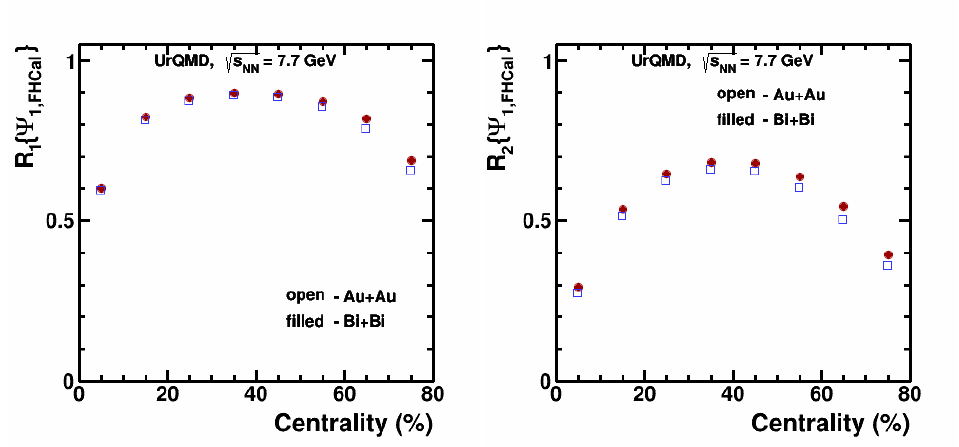
Figure 7. Centrality dependence of event plane resolution factors R n ( Ψ 1,FHCal ) for the directed v 1 ( left ) and elliptic v 2 ( right ) flow measurements for the Au + Au (open symbols) and Bi + Bi (filled √ s NN = 7.7 symbols) collisions at